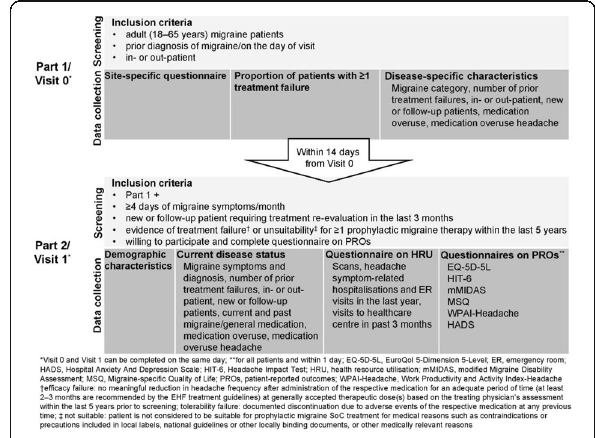
Fig. 1 (abstract P16). BECOME study design and data collection during Parts 1 and